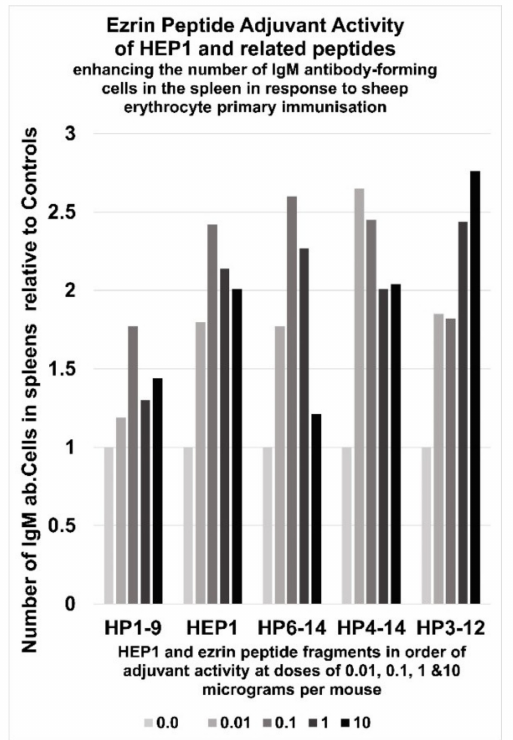
Figure 10. Ezrin peptide adjuvant activity of HEP1 and related peptides, enhances the number of IgM antibody-forming cells in the spleens of mice in response to sheep erythrocyte primary immunisation. HP1–9 TEKKRRETV, HEP1 TEKKRRETVEREKE, HP6–14 RETVEREKE, HP4–14 KRRETVEREKE and HP-3–12